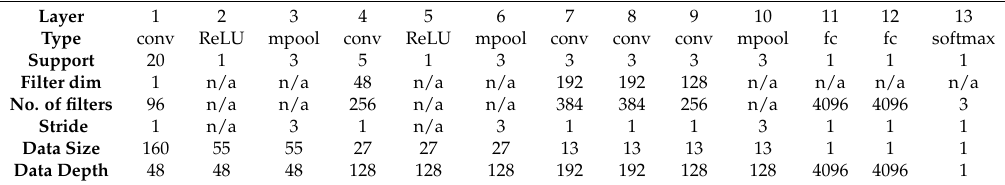
Table 5. The parameter design of our Convolutional Neural Network